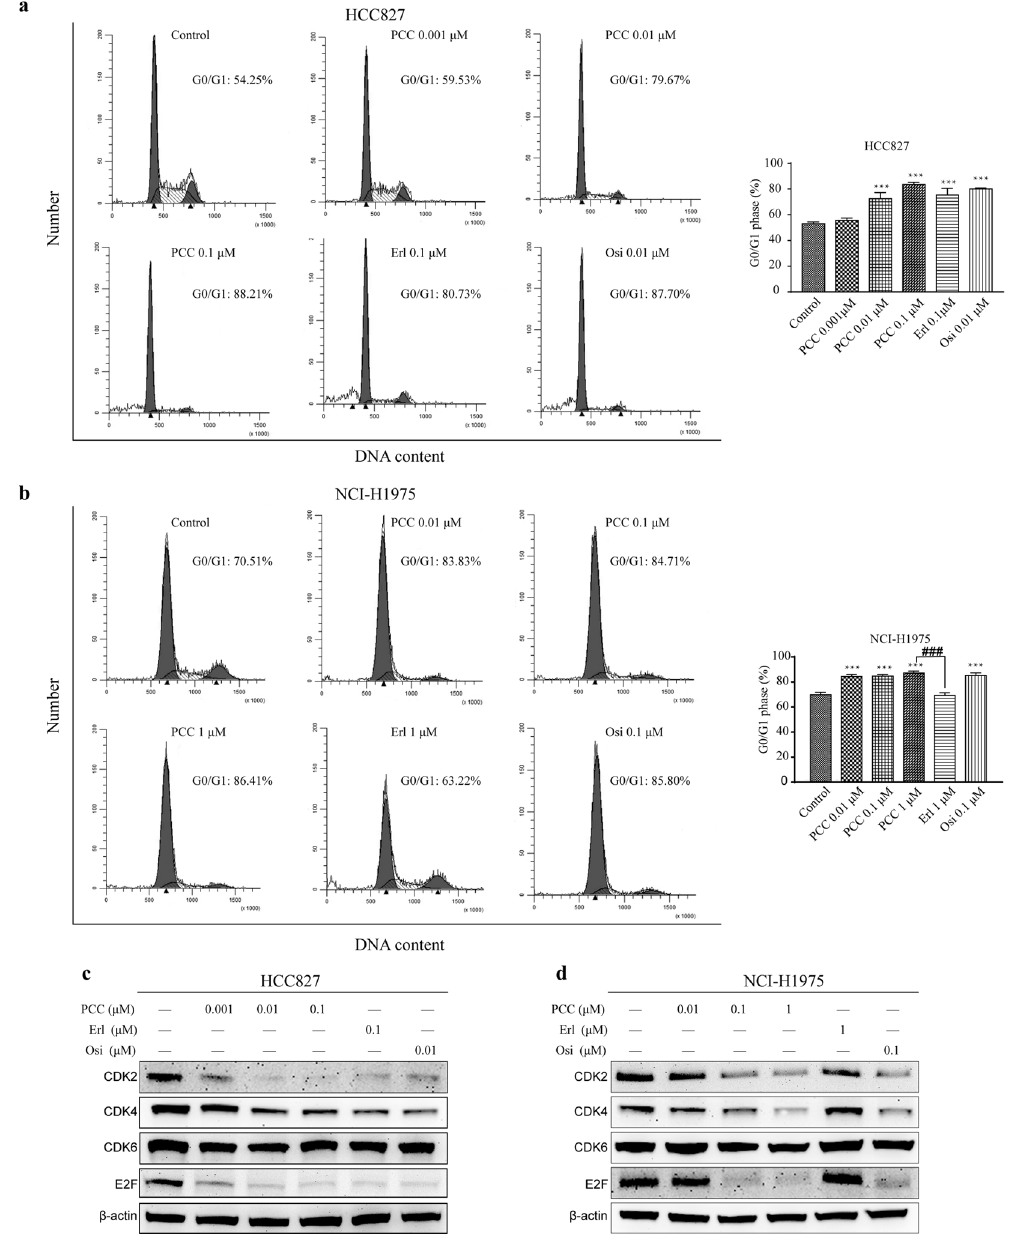
Figure 2. Effect of PCC0208027 on cell cycle progression. ( a ) HCC827 and ( b ) NCI-H1975 cells were fixed and stained with PI following treatment with PCC0208027, erlotinib, and osimertinib for 24 h. Cell cycle distribution was then detected using flow cytometry. PCC0208027 and osimertinib induced G0/G1 arrest in both HCC827 and NCI-H1975 cells, but erlotinib did not in NCI-H1975 cells. Columns, mean; bars, s.d. (n = 3). *** P < 0.001, compared to control group. ### P < 0.001, compared to erlotinib group. ( c , d ) HCC827 and NCI-H1975 cells were treated with various concentration of PCC0208027, erlotinib, and osimertinib for 24 h. The proteins associated with cell cycle were checked by western blot assay. PCC0208027 treatment significantly decreased the expression of CDK2, CDK4 and the nuclear transcription factor E2F. The full-length blots are presented in the Supplementary Materials. The gels were operated under the same experimental conditions in HCC827 and NCI-H1975 cells,